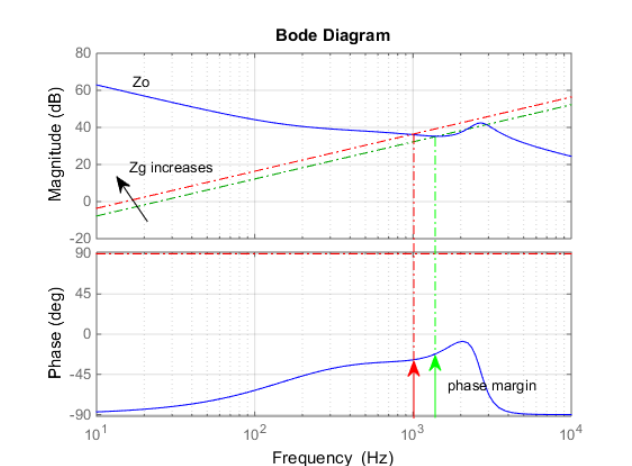
Fig. 5. Bode plot of the inverter output impedance and different grid